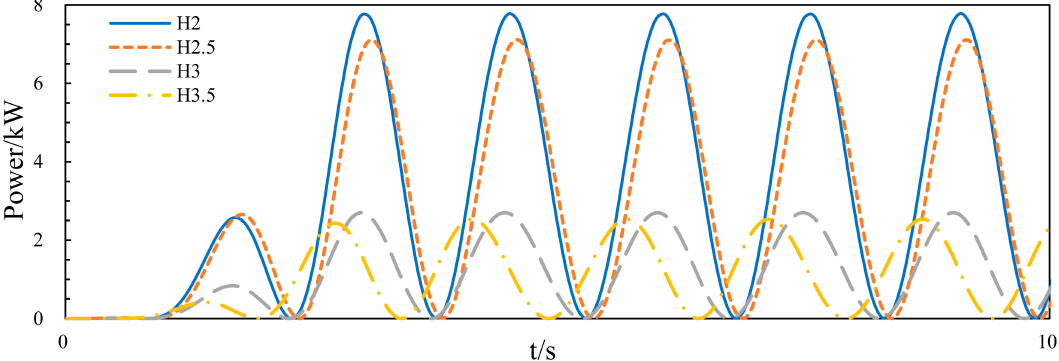
Figure 16. The instantaneous power curves of Buoy 1.